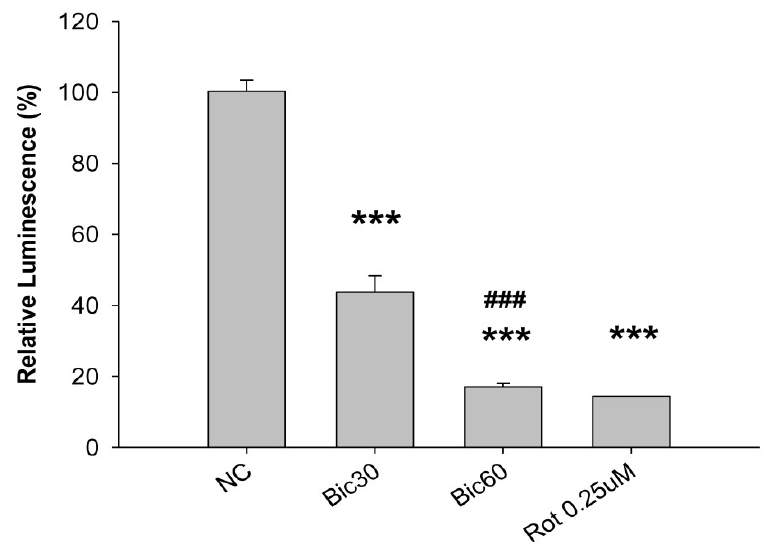
Figure 3. CellTiter-Glo luminescence-based complex I preliminary assay. The ATP content within the RMC cells treated with bicalutamide for 24 h was measured using the CellTiter Glo Luminescent Cell Viability Assay kit (Promega G7570) in the presence of 125 nM antimycin. The luminescence of each well was measured using a Molecular Device SpectraMax ® reader and normalized by expressing it as a fold-change relative to the average luminescence of the appropriate negative control wells on the same plate. The 0.25 μM of rotenone (Rot) is shown as positive control for complex I inhibition. Bar graph represents the mean ± SD of three independent experiments. *** p < 0.001 compared to normal control (NC). ### p < 0.001 compared to Bic 30 μM.